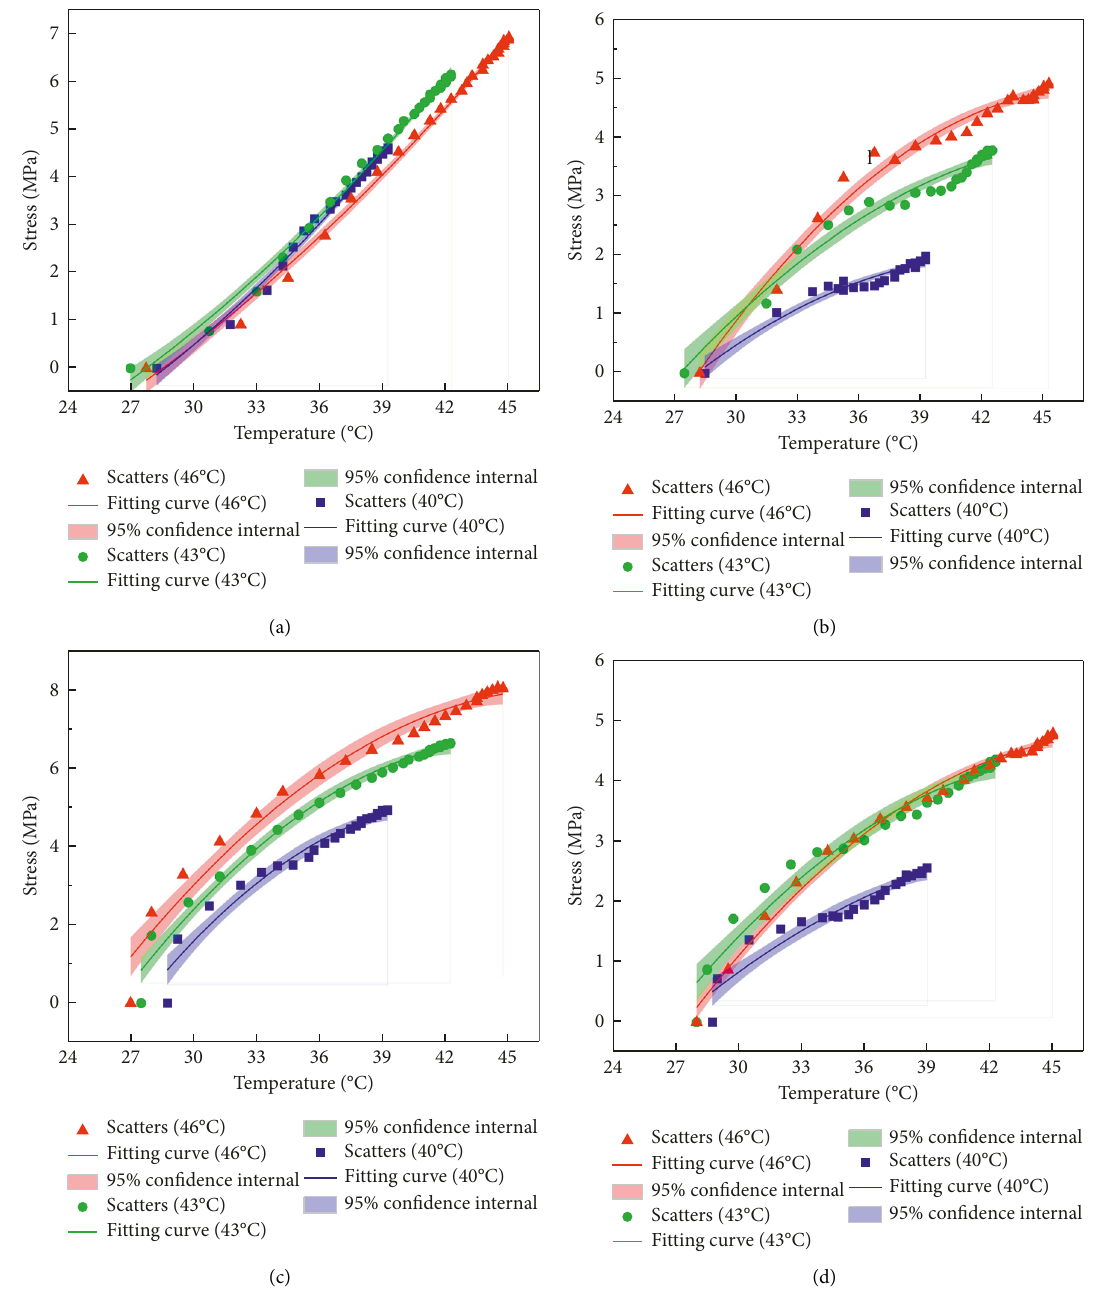
Figure 10: Relationship between the longitudinal stress and the internal temperature under different extreme high-temperature envi- ronments. (a) The constraint track slab, (b) the freedom track slab, (c) the constraint concrete base, and (d) the freedom concrete